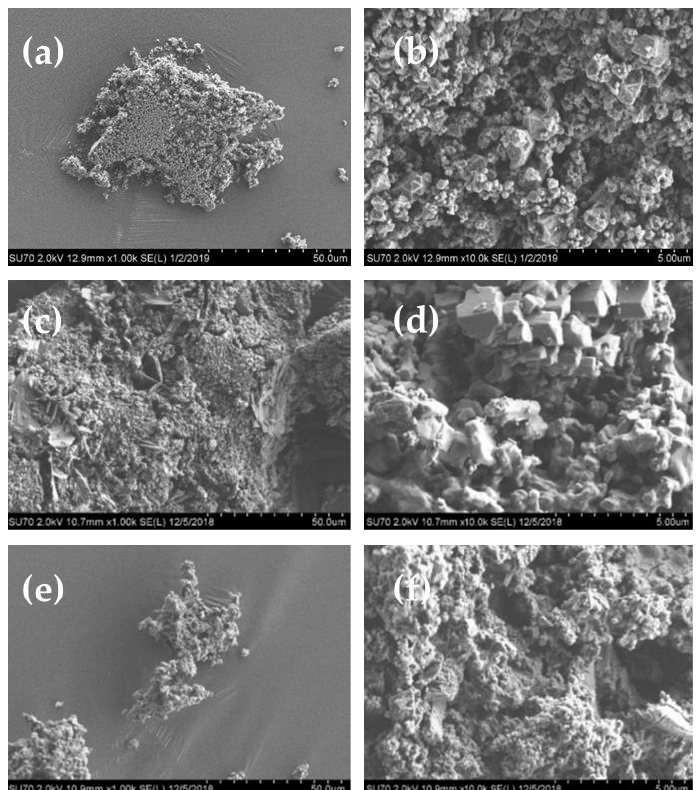
Figure 4. SEM images of MOF-2. Increasing magnification from 1000 × ( a ) to 10,000 × ( b ). SEM images of MOF-3. Increasing magnification from 1000 × ( c ) to 10,000 × ( d ). SEM images of MOF-4. Increasing magnification from 1000 × ( e ) to 10,000 × ( f ). Appl. Sci. 2020 , 10 , x FOR PEER REVIEW